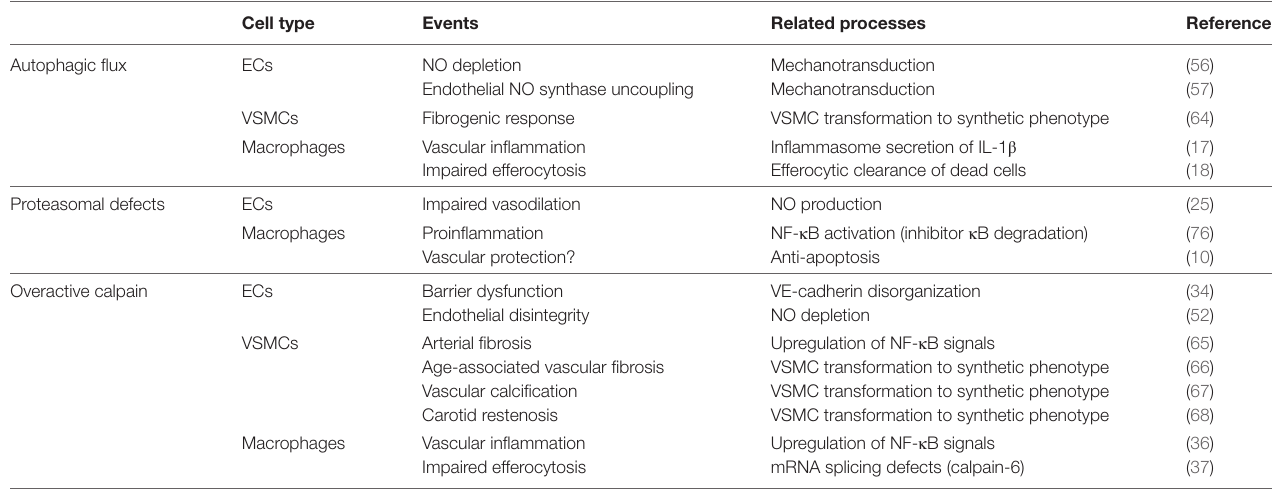
TABLe 1 | Protein catabolism defects and atherosclerosis-related